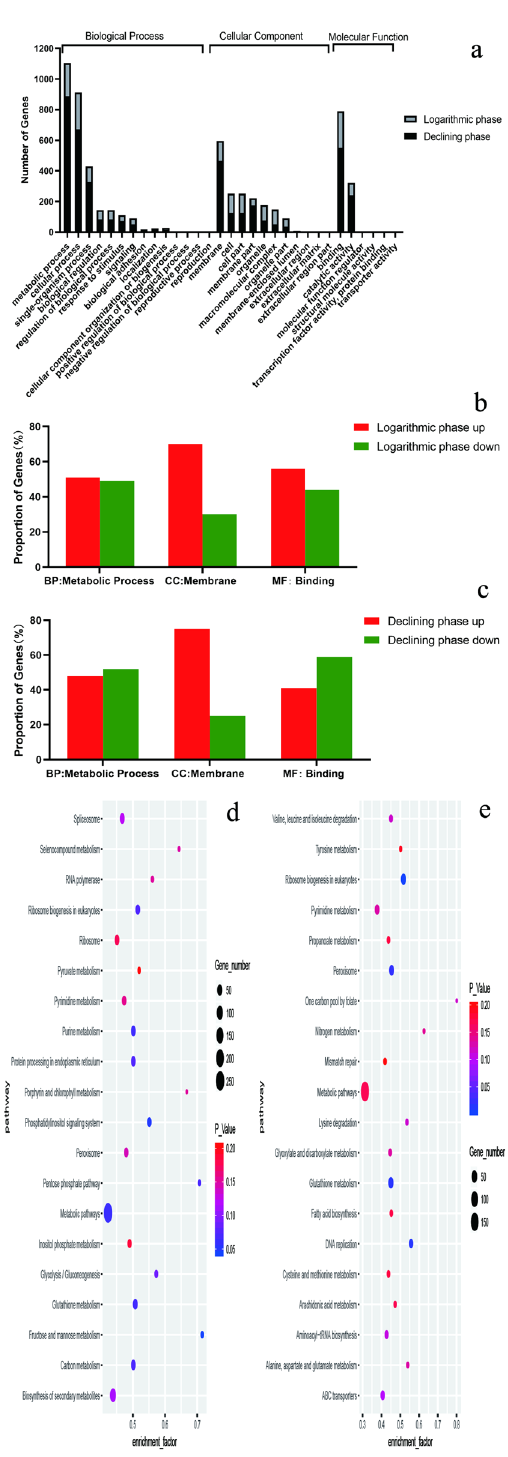
Figure 3. GO enrichment analysis and KEGG pathway enrichment. ( a ) GO enrichment analysis in logarithmic phase and decline phase. ( b ) The proportion of up or down regulated genes in BP, MF and CC in logarithmic phase. ( c ) The proportion of up or down regulated genes in BP, MF and CC in decline phase. ( d ) KEGG enrichment in logarithmic phase. ( e ) KEGG enrichment of different genes in decline